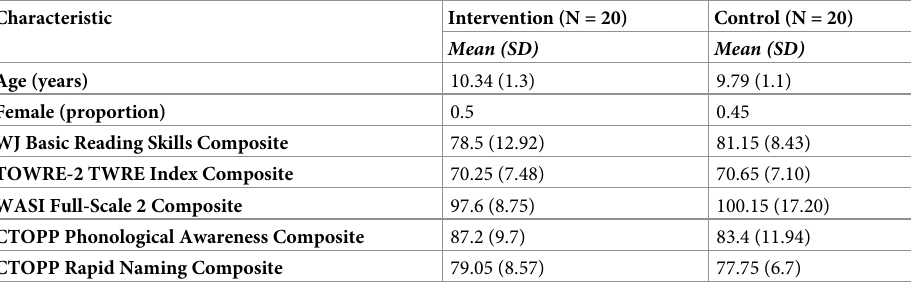
Table 1. Demographic information for study